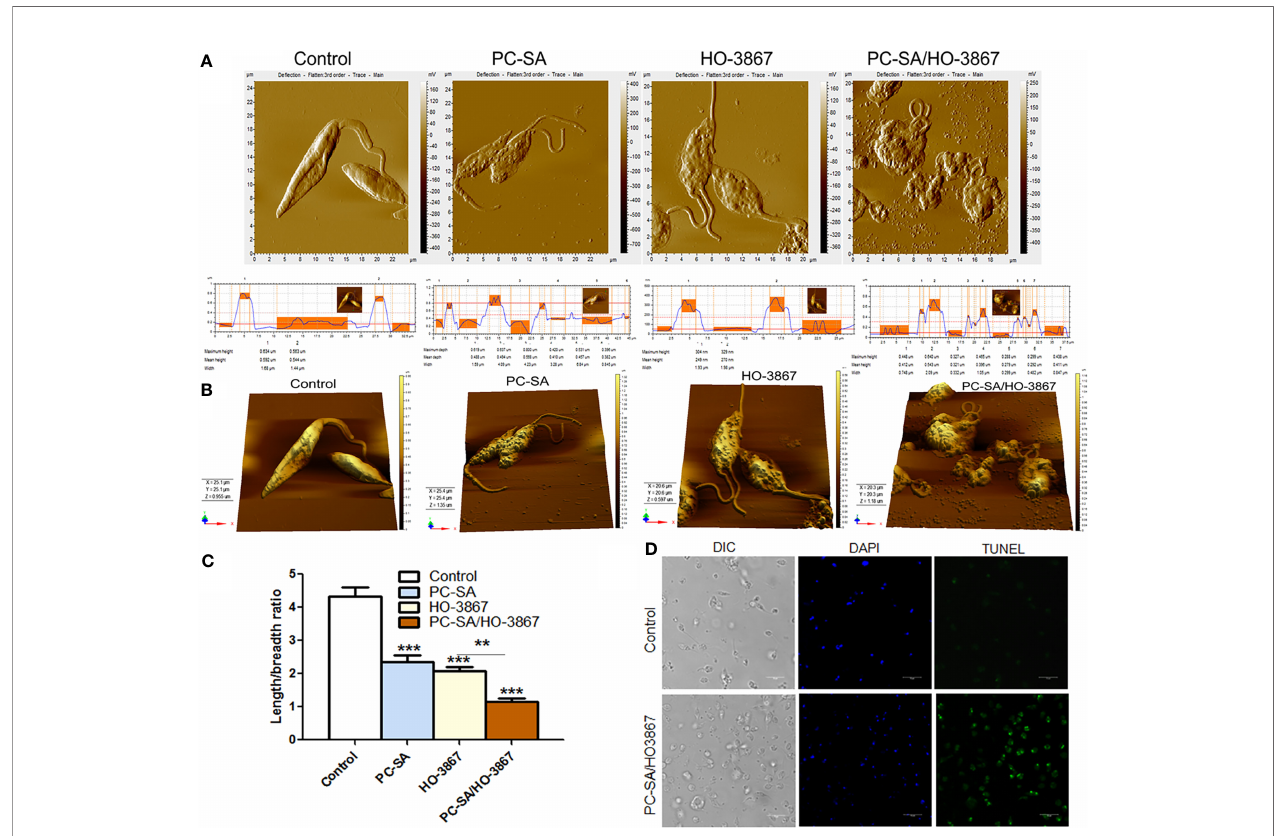
FIGURE 2 | AFM images comparing the effects of free and liposomal HO-3867 upon log-phase promastigotes of L. donovani at half-maximal inhibitory concentration (IC 50 : 10 µg/ml or 21.5 m M). (A) Two-dimensional images of control, HO-3867, empty PC-SA liposomes, and PC-SA/HO-3867-treated promastigotes. Surface smoothness and height are indicated by histograms for control, liposomes, and free and liposomal HO-3867-treated promastigotes in the lower panel. (B) Mean body length/breadth ratio of differently treated promastigotes. Data are mean ± S.E. (n = 3) derived from one of the three independent experiments (*** p < 0.001), calculated by one-way ANOVA and Tukey ’ s multiple-comparison test. (C) Representative 3D images of HO-3867, empty liposomes, and PC-SA/HO-3867-treated promastigotes after 2 h. (D) Confocal images showing genomic DNA fragmentation in controls and liposomal HO-3867-treated promastigotes, using TUNEL staining. Intact nuclei are visualized in blue (DAPI), and TUNEL-positive nuclei are stained green (FITC). The data represent one of the three experiments with similar results. ** p <